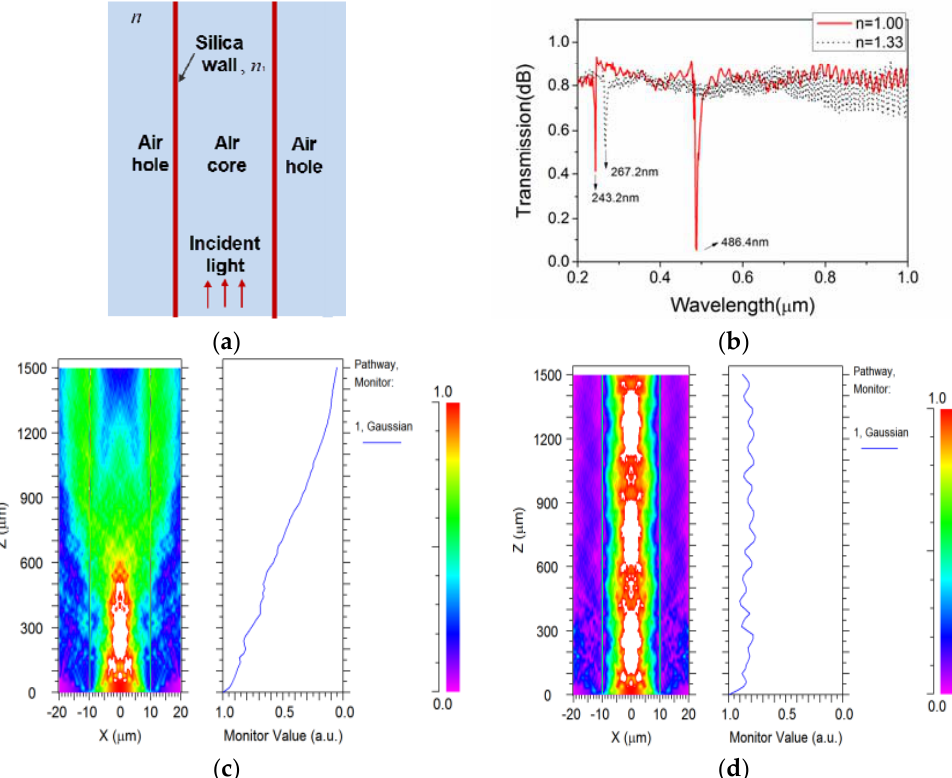
Figure 2. ( a ) Schematic of the SHC-PCF for simulation; ( b ) Transmission spectra from 0.2 µ m to 1.0 µ m as n = 1 and n = 1.33, respectively; ( c ) Side view of simulated 486.4-nm laser transmission in a 1.5-mm SHC-PCF without filling; ( d ) Side view of simulated 785-nm laser transmission in a 1.5-mm SHC-PCF with liquid filled.